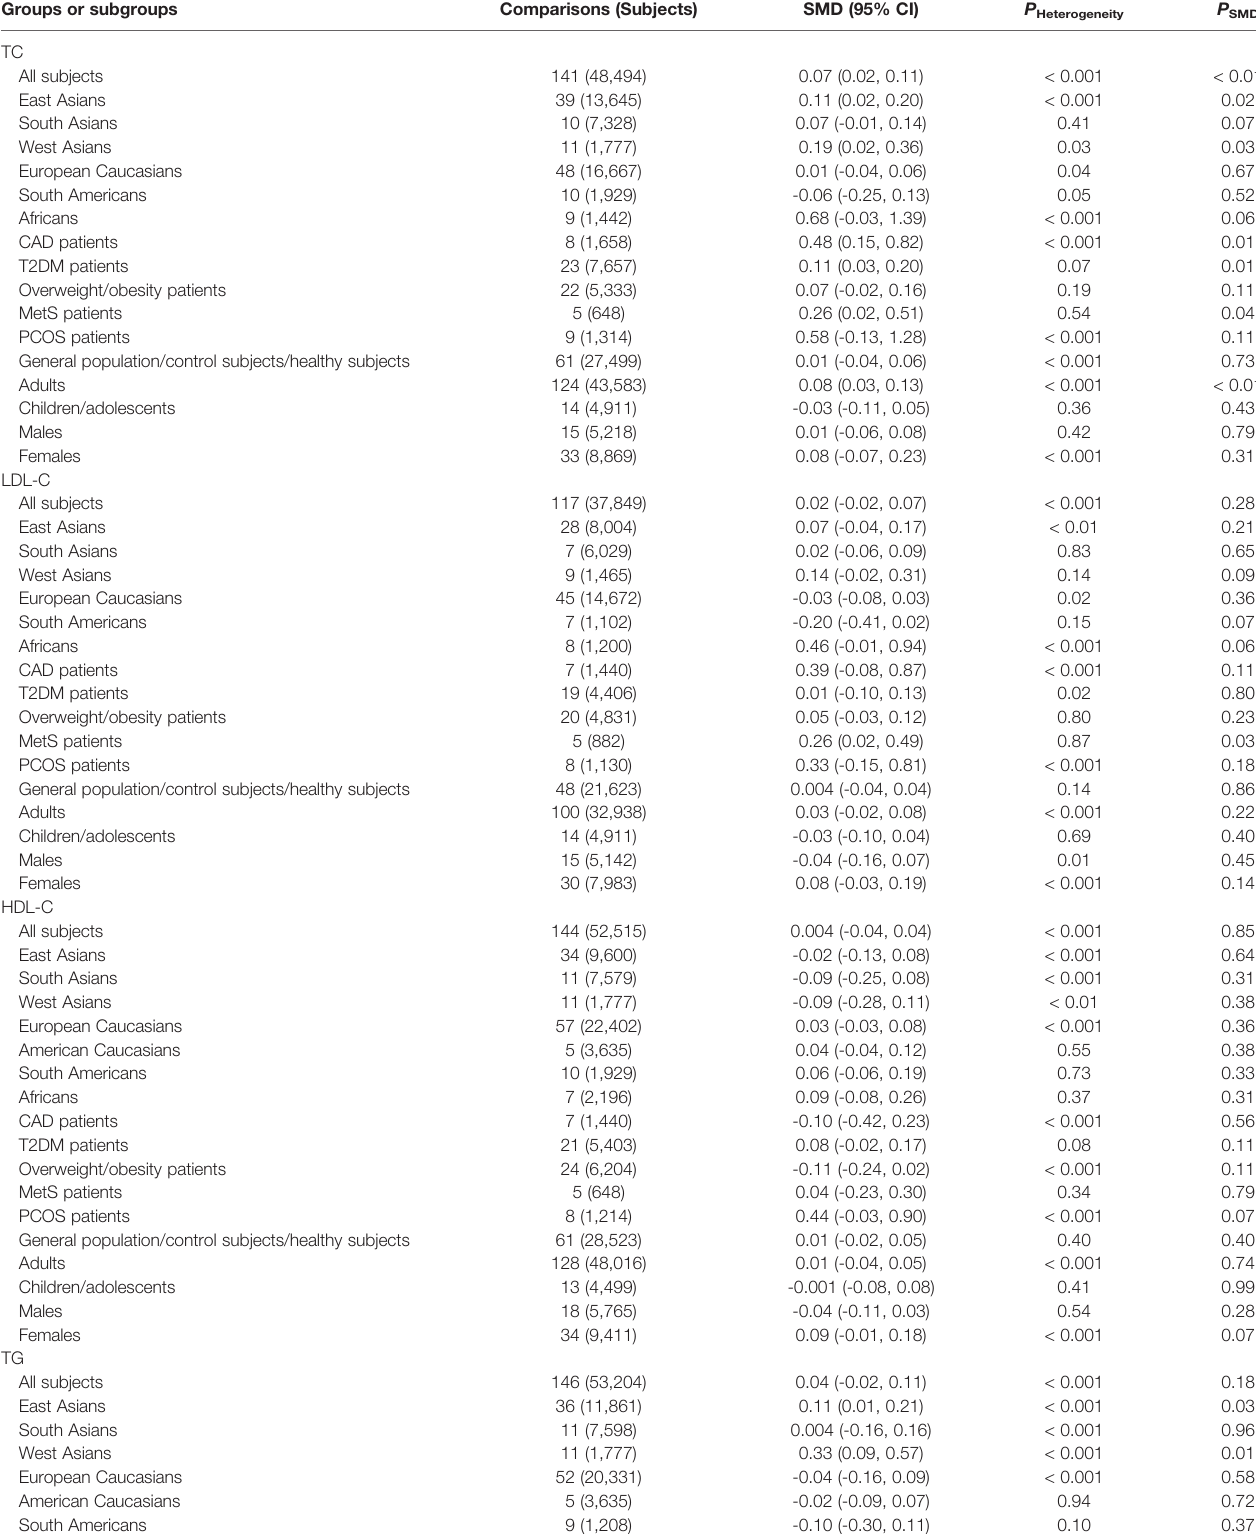
TABLE 2 | Meta-analysis between the rs1801282 polymorphism in PPARG and serum lipid levels. Groups or